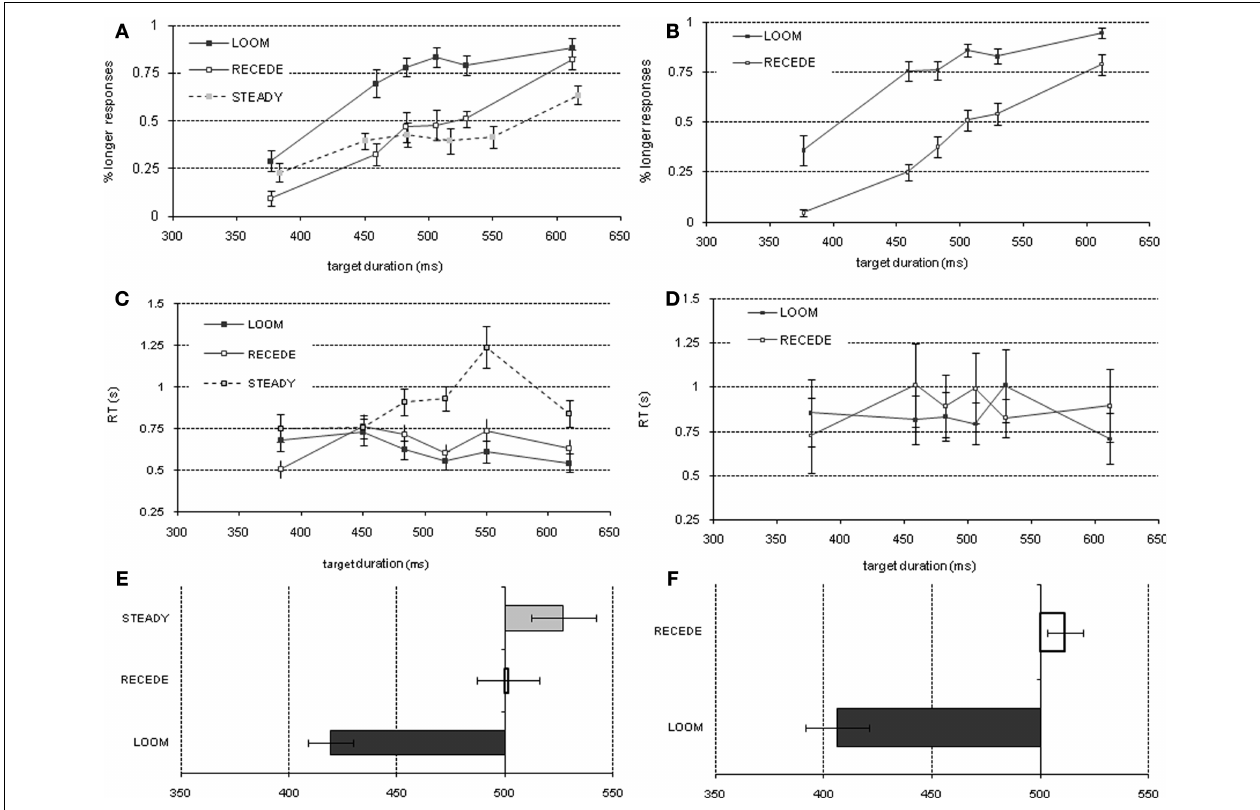
FIGURE 2 | Psychophysical results of pre-fMRI training session (left column) and of the fMRI session (right column): Percent longer responses (pre-fMRI = (A), fMRI = (B)), reaction time (pre-fMRI = (C), fMRI = (D)), point of subjective equality (pre-fMRI = (E), fMRI =